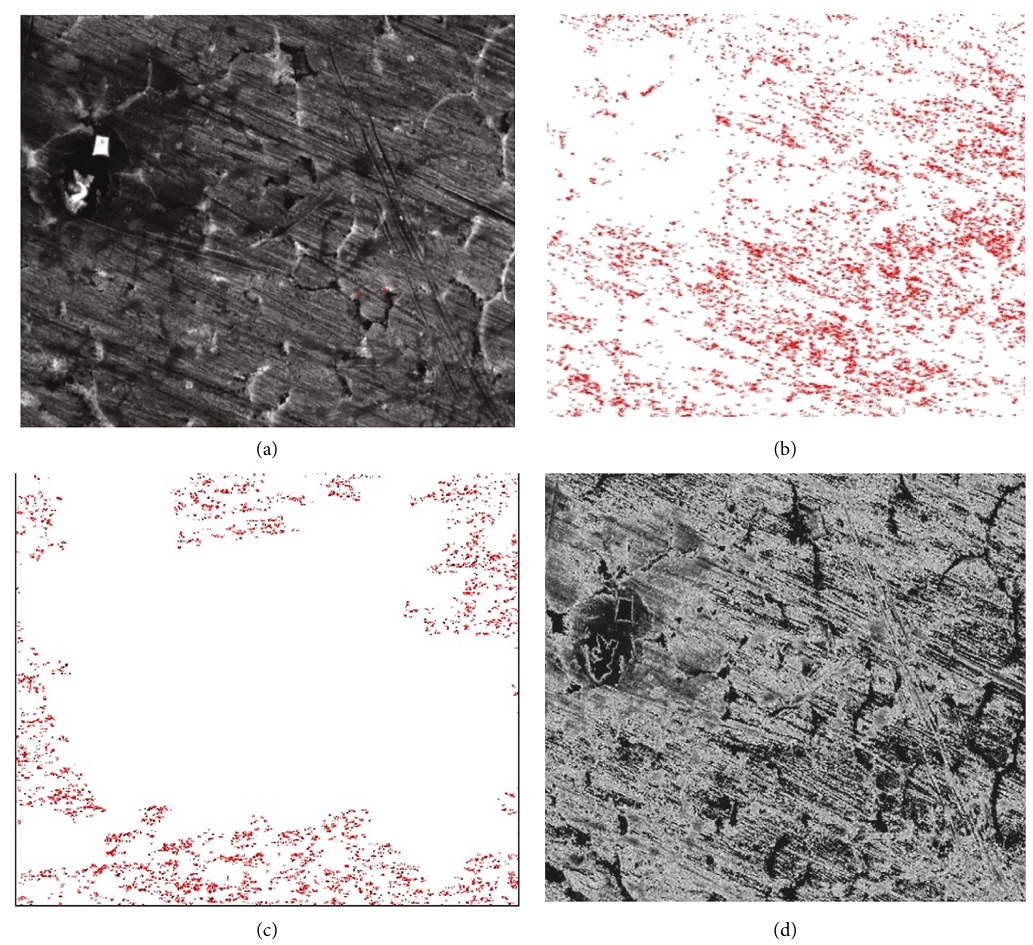
Figure 21: Microstructure analysis for 680 ° c (a) Microstructure at 680 ° c, (b) Nodularity, (c) Porosity, (d)